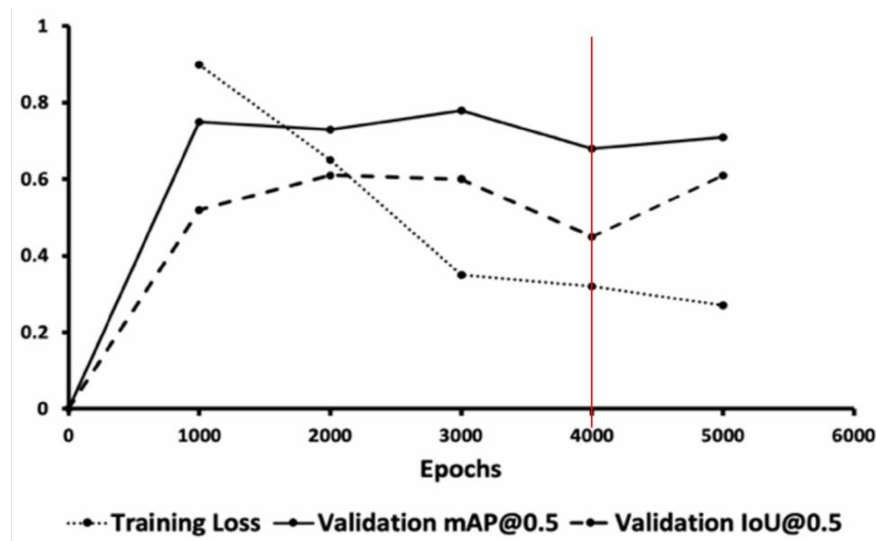
Figure 9. Graph of training loss, validation mAP (mean average precision) and IoU (intersection of union) and red line is the optimal weight with lowest training and validation loss, and highest mAP.